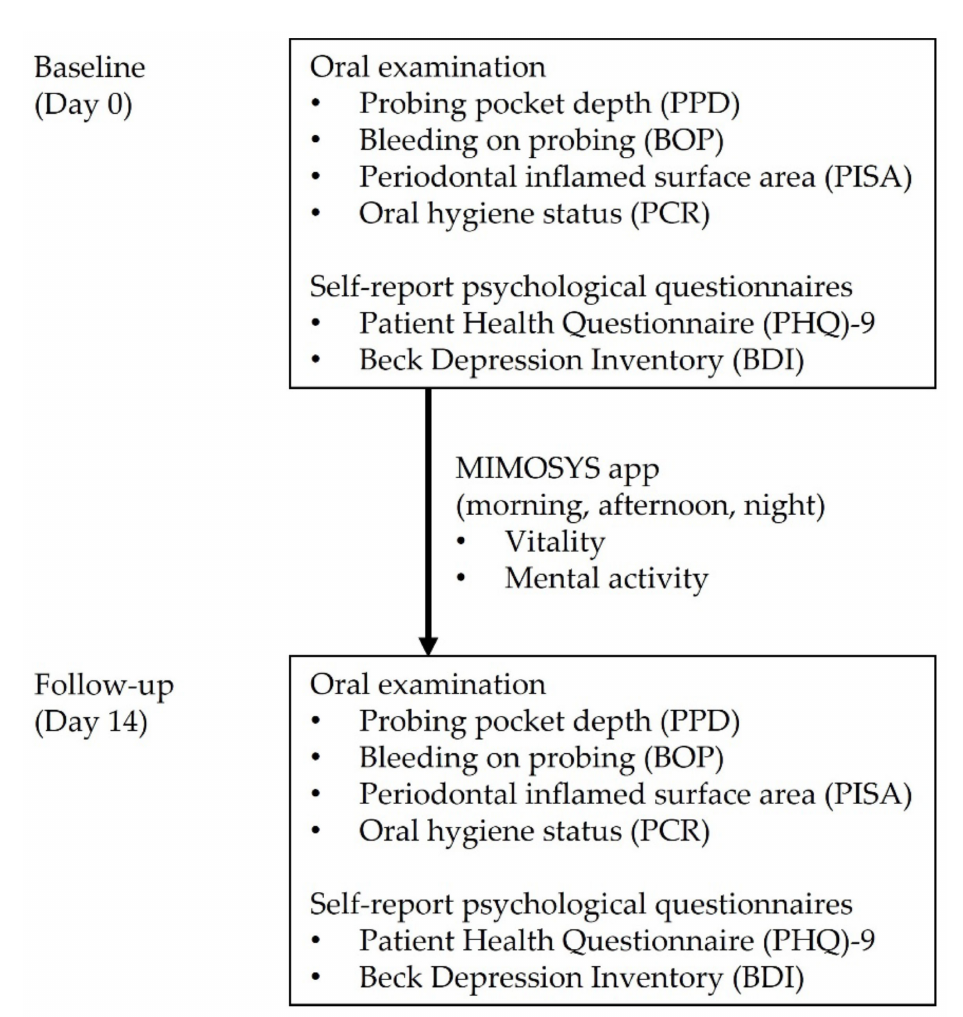
Figure 1. The protocol of this study.